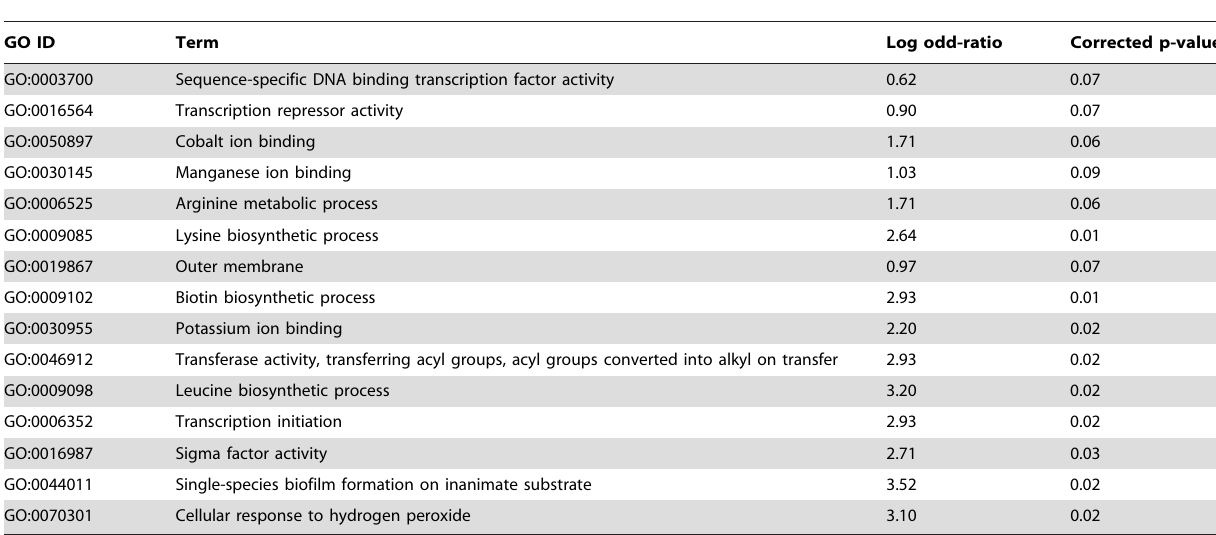
Table 2. Gene Ontology terms enriched in the enriched set of genes.